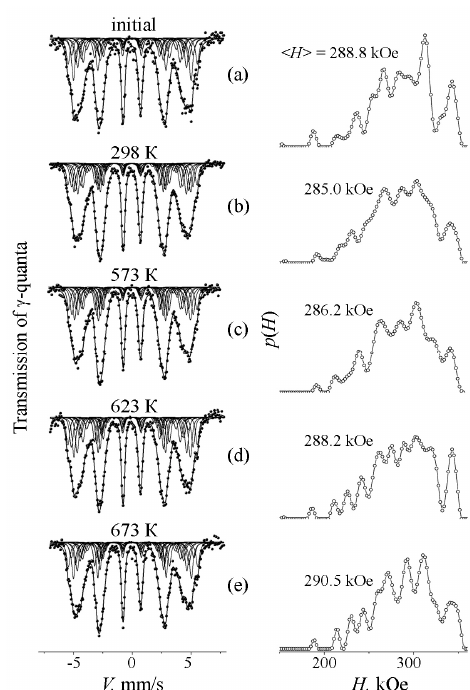
Figure 2. Mössbauer spectra, distributions p ( H ), and values of < H > for the alloy Fe-16Cr-Sb in the initial state and after HPT ( ε = 5.9, n = 3 rev.) at different temperatures: ( a )—initial state (annealed at 1073 K, 4 h); ( b )—HPT at 298 K; ( c )—HPT at 573 K; ( d )—HPT at 623 K, and ( e )—HPT at 673 K. Mössbauer spectra were measured at room temperature.